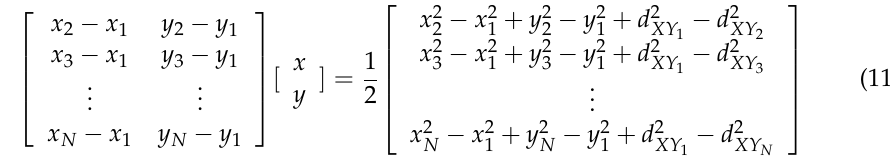
(cid:112) − h 2 using Figure 16— h being the ceiling height) from luminaire d 2 n